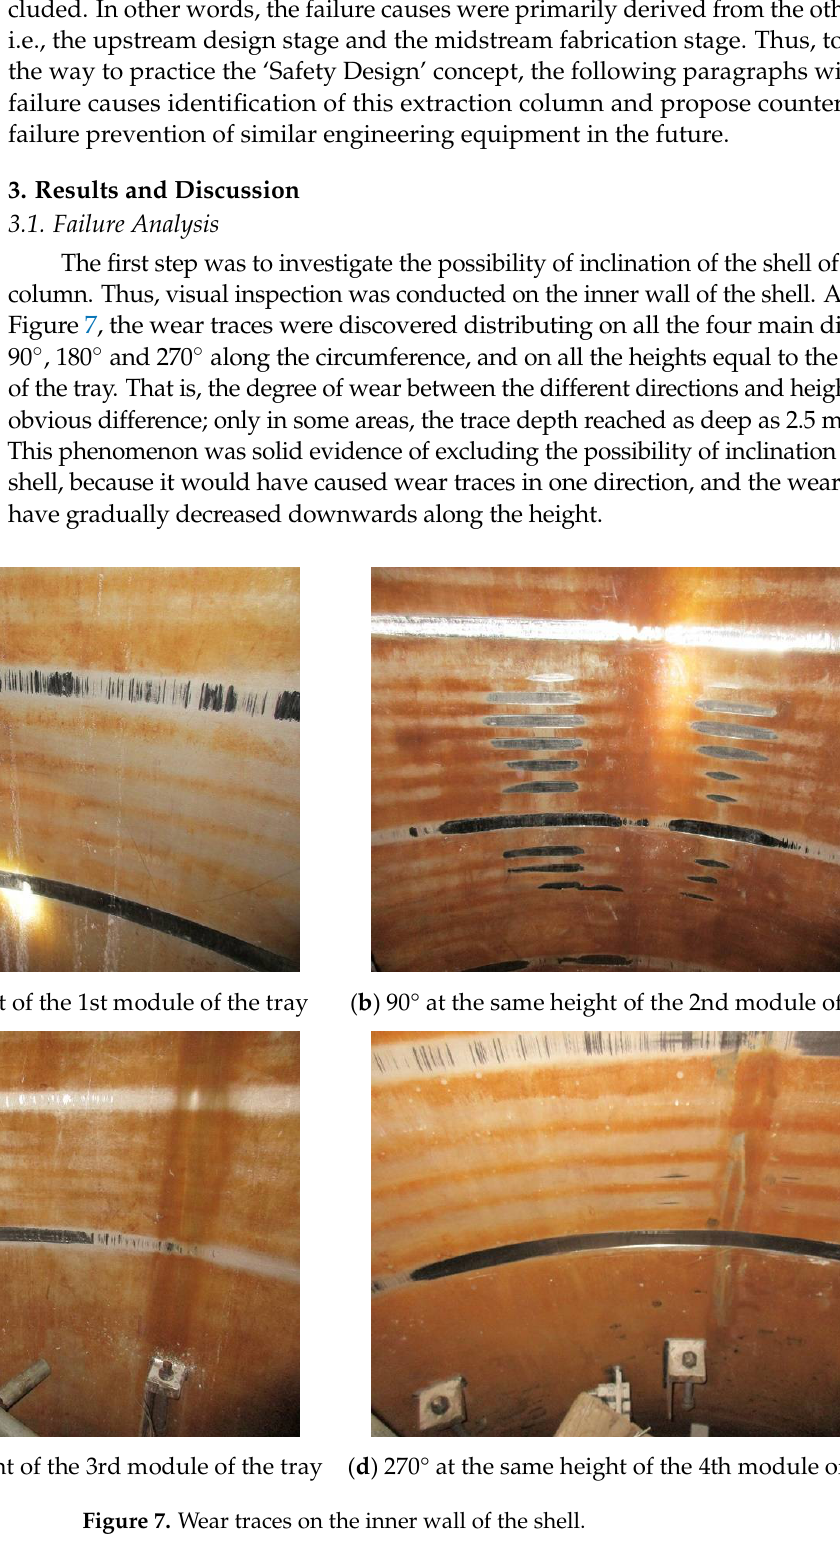
Figure 7. Wear traces on the inner wall of the shell.